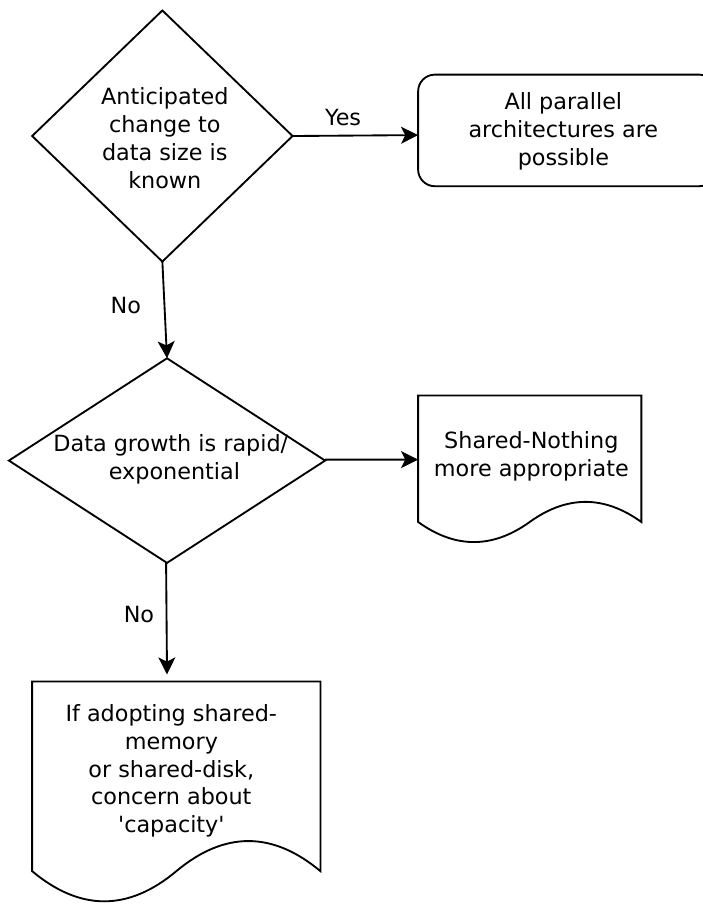
Figure 3. Choosing parallel architectures based on anticipated changes to data